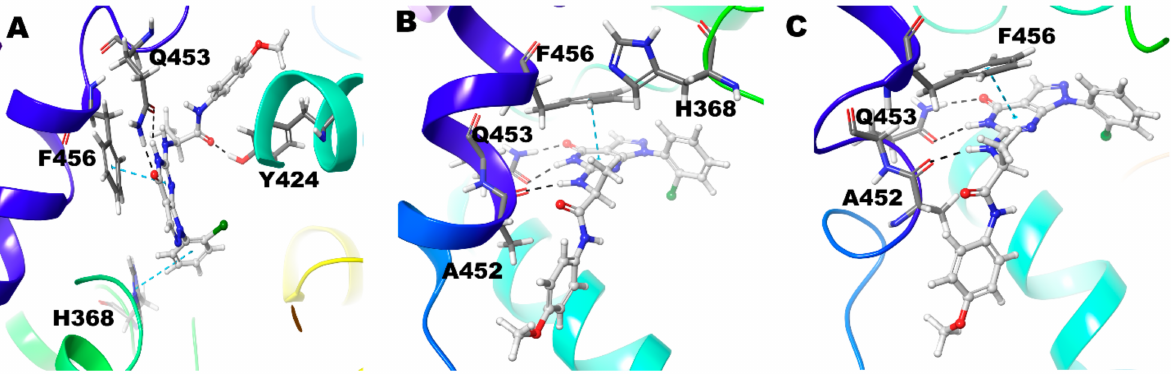
Figure 6. Non-bonded interactions of Compound 2 ( S ) in ( A ) PDE9 Zn/Mg ( B ) PDE9 Mg/Mg ( C ) PDE9